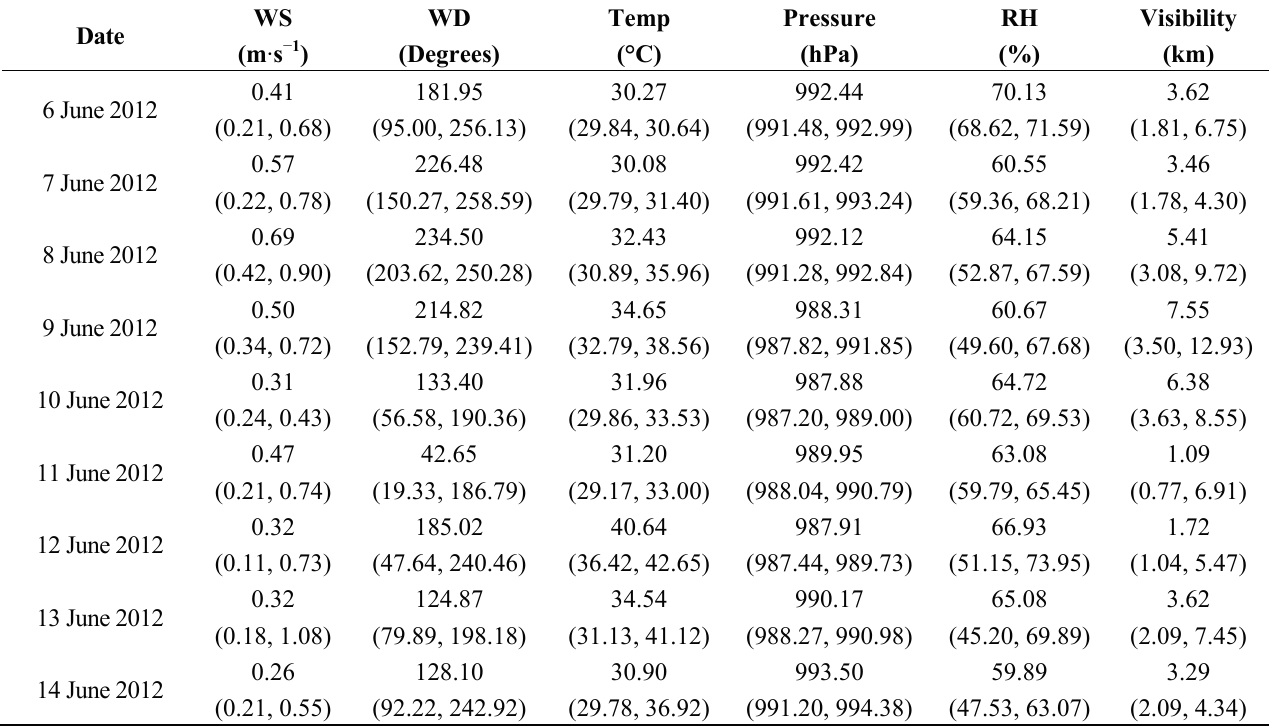
Table 1. Meteorological information obtained during the